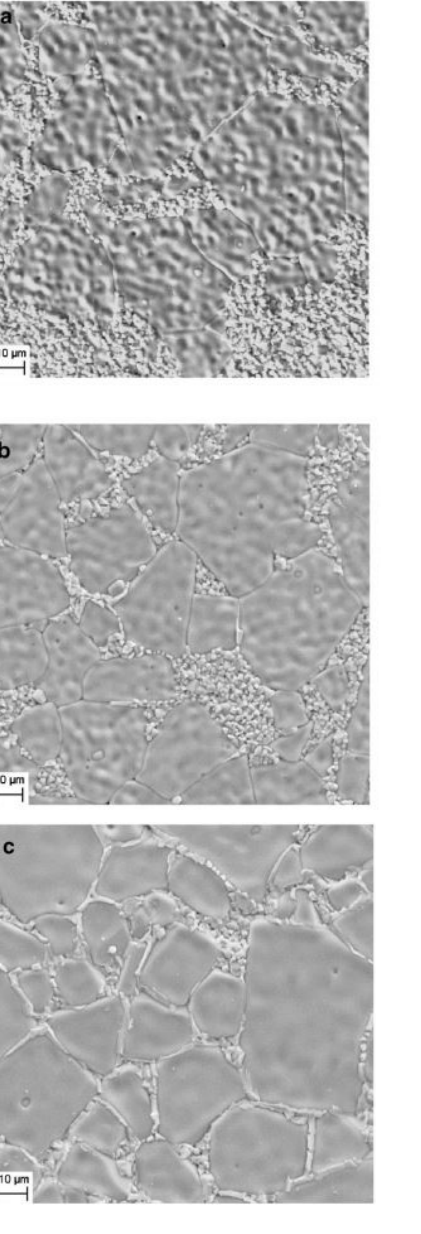
Figure 5. FE SEM images of samples sintered at ( a ) 1050 ◦ C/2 h, ( b ) 1050 ◦ C/4 h, ( c ) 1050 ◦ C/12 h, ( d ) 1100 ◦ C/2 h, ( e ) 1100 ◦ C/4 h, ( f ) 1100 ◦ C/12 h